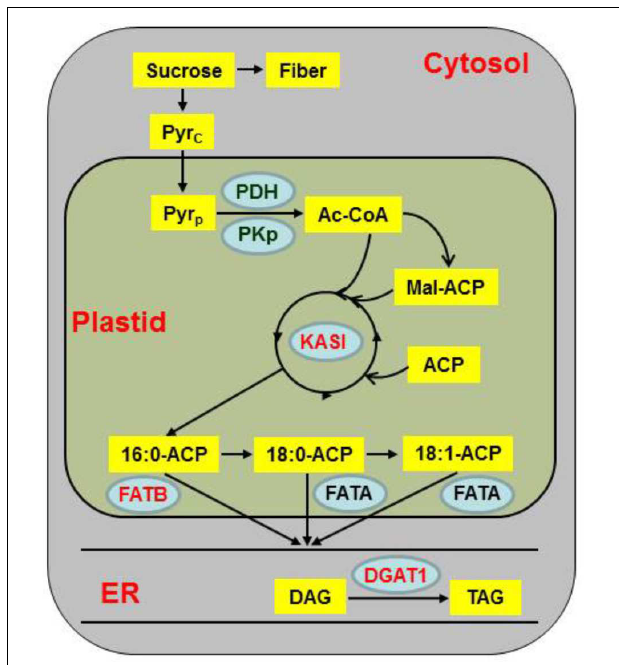
FIGURE 8 | A working model for the role of JcWRI1 in both controlling carbon partitioning and lipid biosynthesis in Jatropha seeds. In this framework, WRI1 appears as a key gene, acting at the interplay between the carbon flow and lipid metabolism. JiWRI1 possess a loss of function due to an ATA-insertion in conserved site, resulting in a significant differences in carbon partitioning and lipid quality between the two Jatropha species ( Jatropha curcas and J. integerrima ). Overexpression of JcWRI1 in J. curcas increases the lipid content but also the ratio between oleate and linoleate by upregulating fatty acid biosynthesis and regulation genes. Among them, the diacylglycerol acyltransferase gene DGAT1 , representing rate-limiting enzymes in plant lipid accumulation, the β -ketoacyl-ACP synthase I gene KAS I , catalyzing the initial step of FA biosynthesis and the palmitoyl ACP thioesterase gene FATB2 , encoding enzyme for producing palmitic acids (the red fonts in the blue circles in Figure 8 ) were directly upregulated by JcWRI1 ( Figure 7C ). And the pyruvate dehydrogenase gene PDH , the pyruvate kinase gene PKp , the biotin carboxyl carrier protein 2 gene BCCP2 , the β -ketoacyl-[acyl carrier protein] synthase III gene KASIII , the acyl carrier protein gene ACP1 and the stearoyl-acyl carrier protein thioesterase gene FATA were indirectly upregulated by JcWRI1 ( Figure 7A and the blue circles in Figure 8 ). The yellow boxes indicated the chemical substances participating in lipid biosynthesis. The blue circles represented the protein upregulated by JcWRI during lipid biosynthesis. Among them, the red fonts meant the corresponding genes were directly upregulated by JcWRI. Pyr, pyruvate; Ac-CoA, acetyl-CoA; ACP, acyl carrier protein; Mal-ACP, malonyl-ACP; DAG, diacylglycerol; TAG, triacylglycerol; PDH, pyruvate dehydrogenase; PKp, pyruvate kinase; KASI, β -ketoacyl-[acyl carrier protein] synthase I; FATA, stearoyl-acyl carrier protein thioesterase A; FATB, palmitoyl-acyl carrier protein thioesterase B; DGAT1, diacylglycerol acyltransferase; ER, endoplasmic